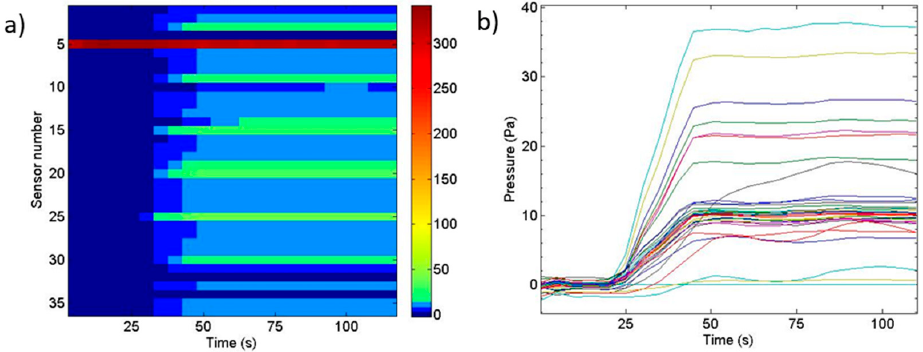
Figure 18. Evolution of the pressure value over time for each sensor using a colormap in ( a ) and plotted in ( b ).